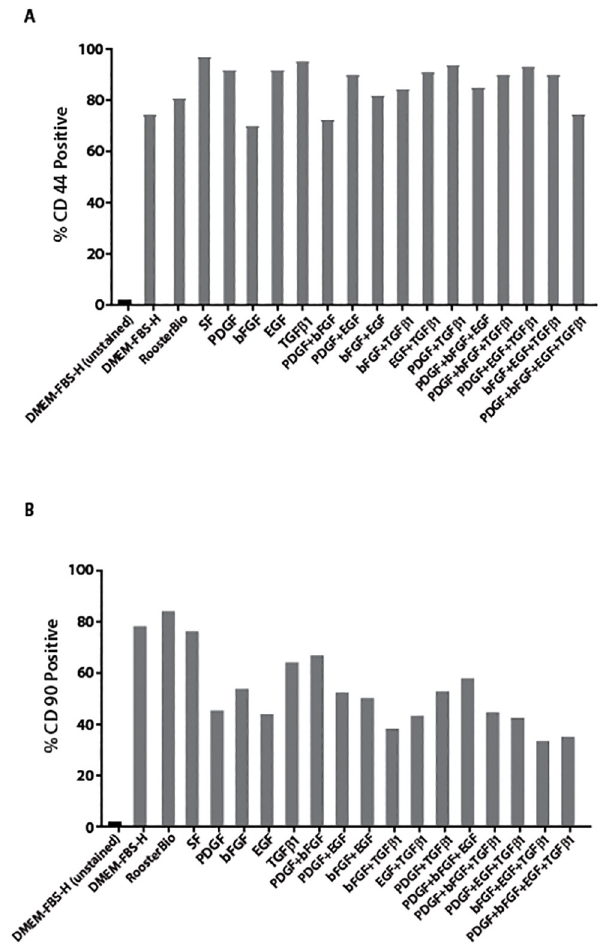
Fig 6. Immunophenotyping of canine Ad-MSCs cultivated in DMEM/FBS-H or serum-free medium. A . Analysis for the CD44 expression on canine Ad-MSCs cultured in serum-free medium supplemented with the indicated growth factors or DMEM/FBS-H. B . Analysis for the CD90 expression on canine Ad-MSCs cultured in serum-free medium supplemented with the indicated growth factors or DMEM/FBS-H. Y-axis represents % positive cells and X-axis represents the culture medium. SF = na ï ve serum-free